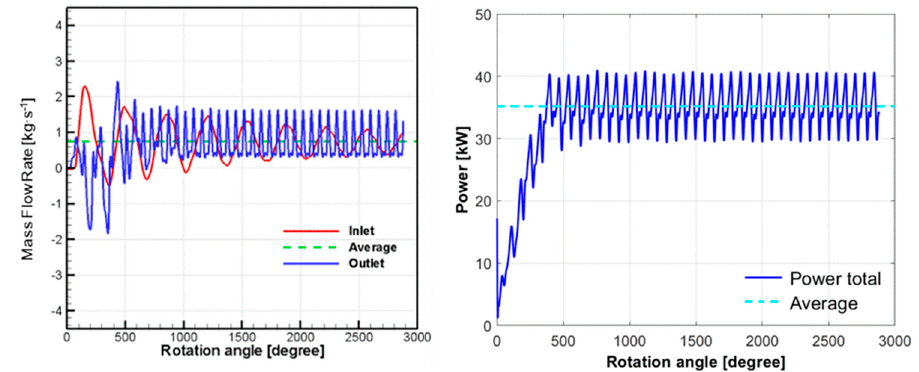
Figure 5. CFD results vs. rotation angle of male rotor for mass fl ow rate and power input.